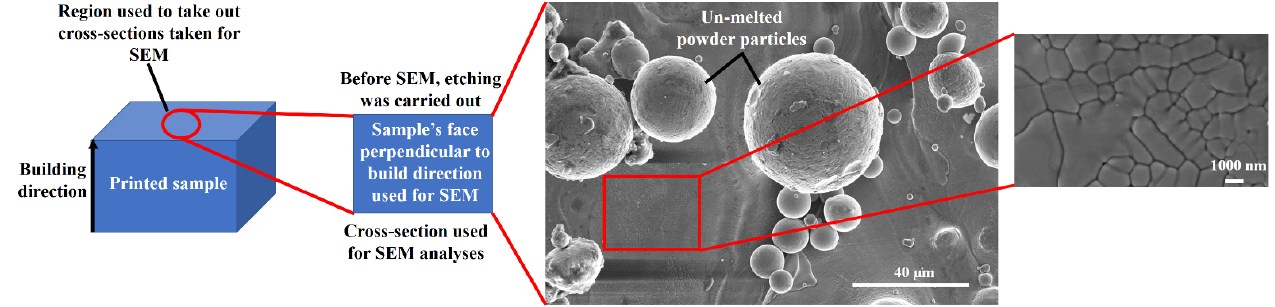
Figure 4. The methodology applied to conduct scanning electron microscopy (SEM) on the printed parts. Table 2 . Step ‐ by ‐ step procedure to carry out grinding and polishing .